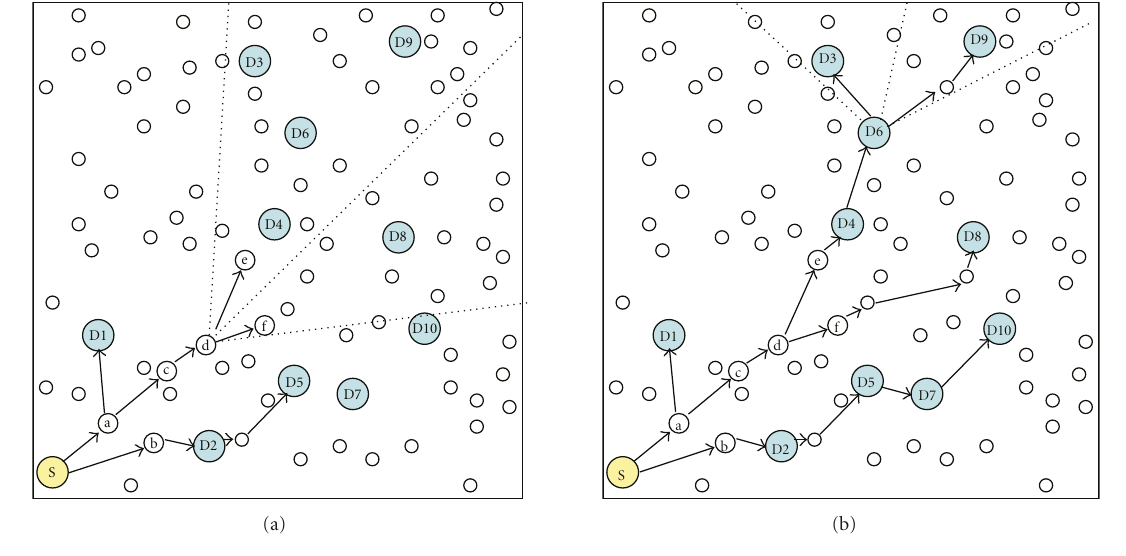
Figure 2: A sample run of LBM-D with 10 destinations